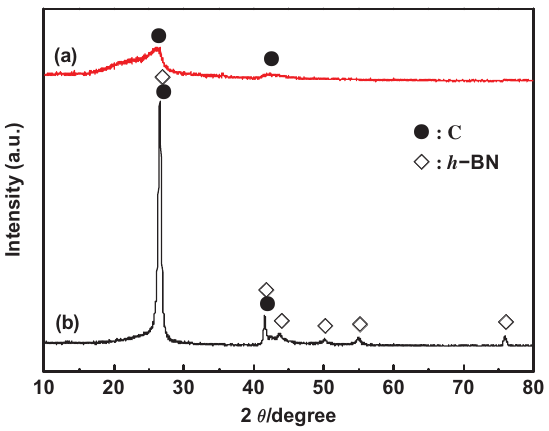
Figure 2: XRD spectra of (a) the pure CB and (b) the BN-coated CB.